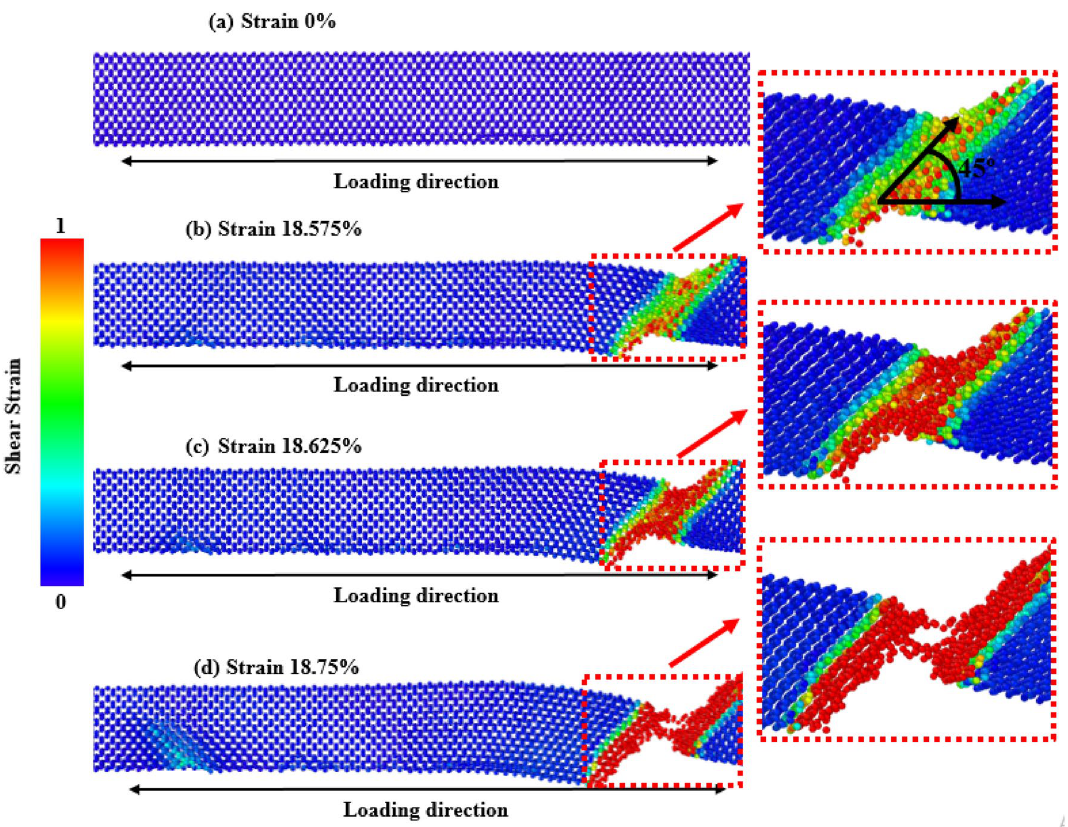
Figure 7. Tensile deformation profiles of [110] directed 15.76 nm 2 zinc-blende ZnSe NWs for various strain levels at 300 K. Dislocation slipping induced cleavage plane along an angle of 45° with the applied tension is shown in the zoomed-in